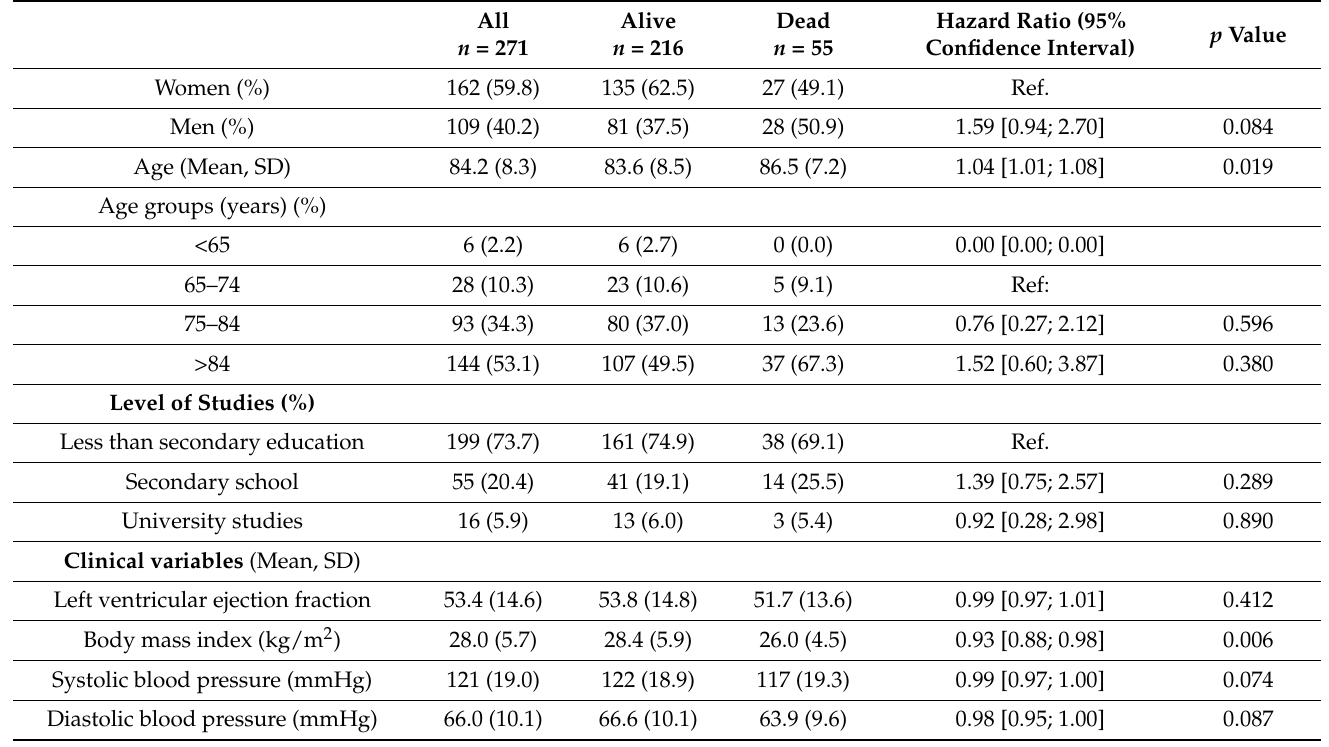
Table 1. Univariate analysis of variables related to short-term (three months) mortality in patients at NYHA